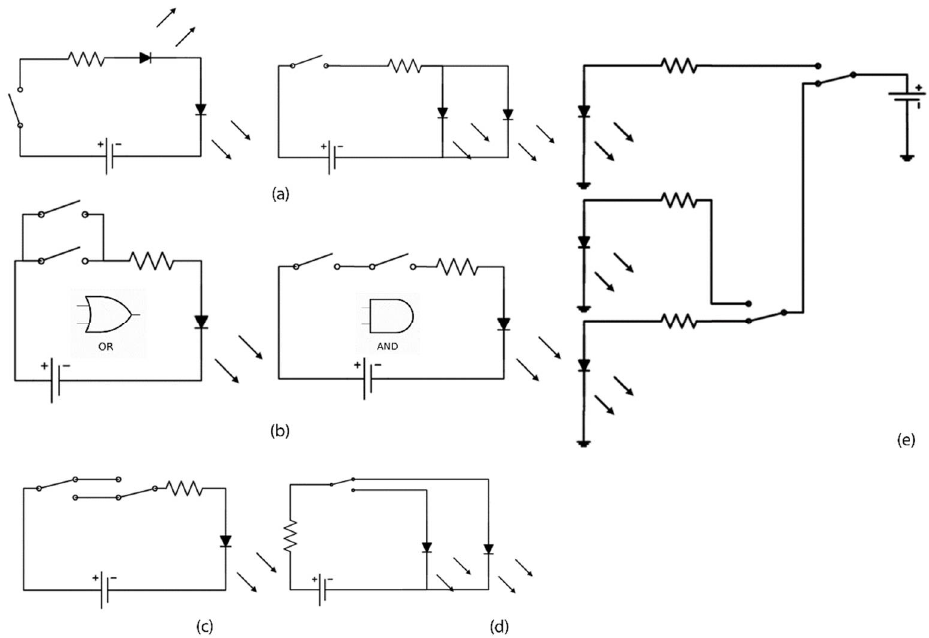
Figure 4. Examples of breadboard exercises offered during the introductory hands-on electricity activities: ( a ) parallel and serial LED connections; ( b ) circuitry analogues of the basic logical operators (placed inside); ( c ) two-way LED switching; ( d ) LED toggling; ( e ) traffic light model.